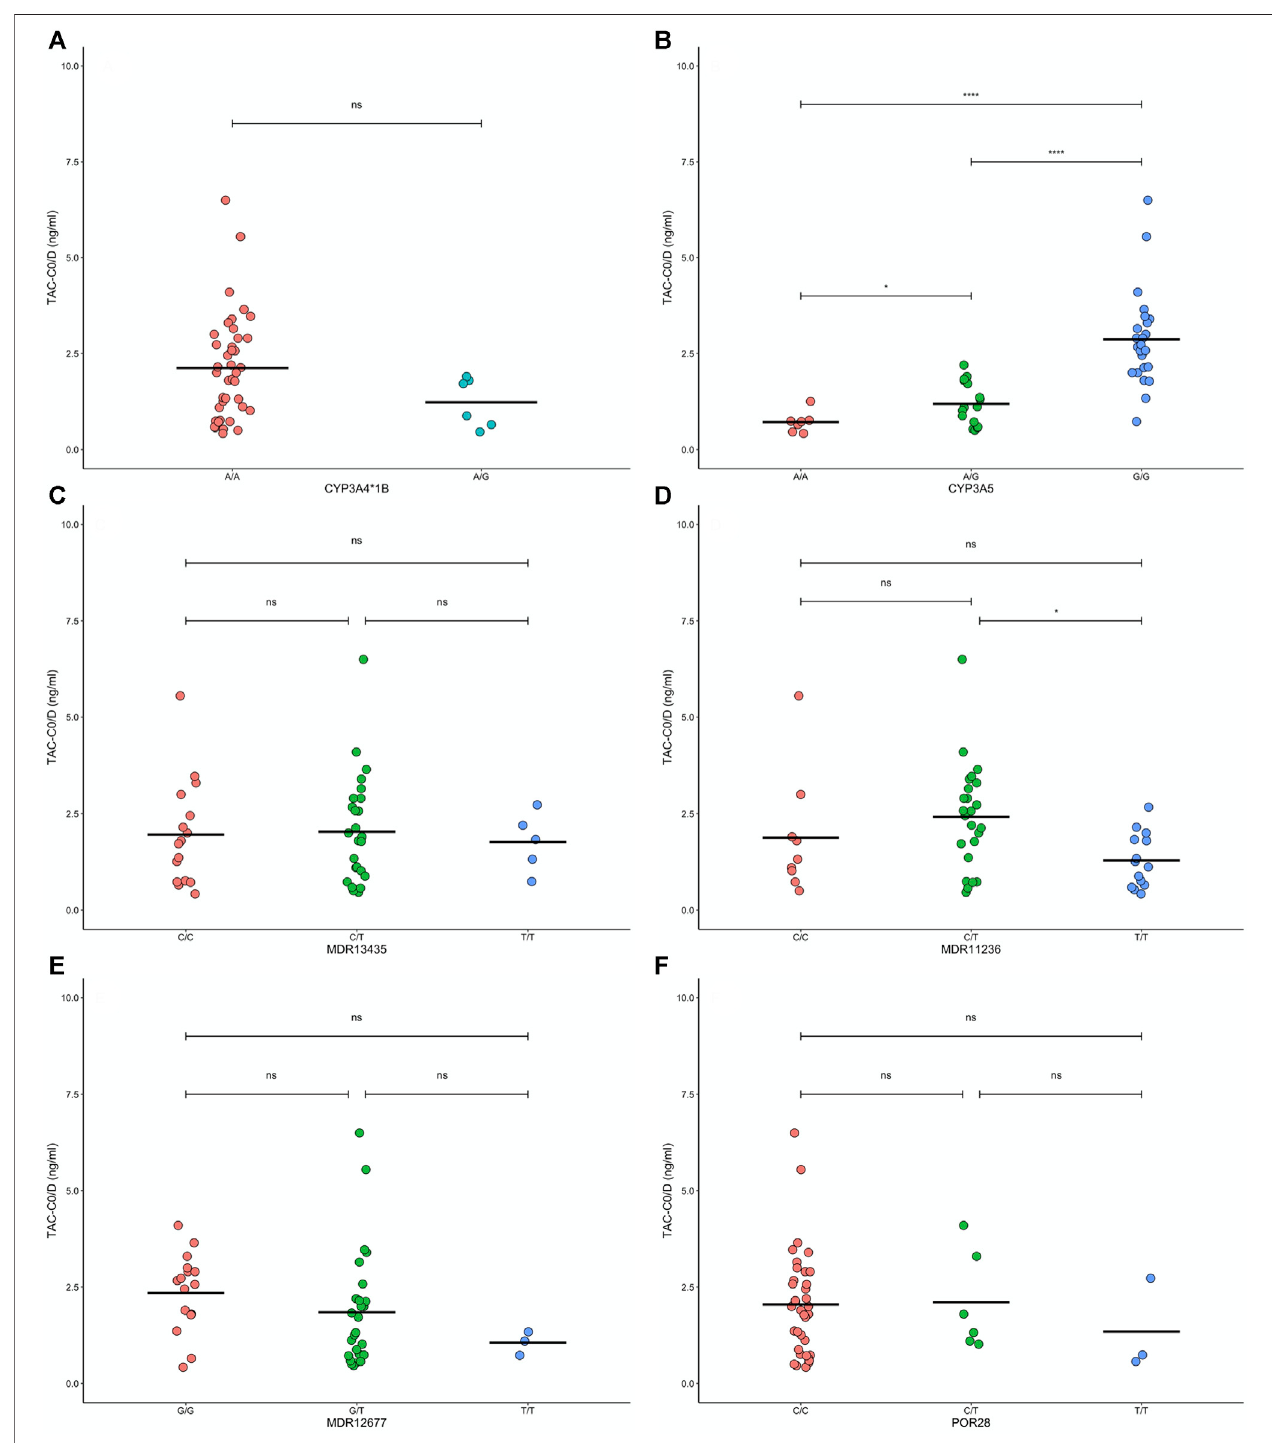
FIGURE3| Levelsoftacrolymus(TAC)normalizedbydosebeforeadministration(TACC0/D)for50patientswithdifferent (A) CYP3A4*1B, (B) CYP3A5, (C) MDR1- 3435, (D) MDR1-1236, (E) MDR1-2677, and (F) POR28 genotypes. Paired comparisons between genotypes using Bonferroni-adjusted t- tests are they results are indicated as nonsigni fi cant (ns: p > 0.05) or signi fi cant (* p < 0.05, ** p < 0.01, *** p < 0.001, and **** p < 0.0001).